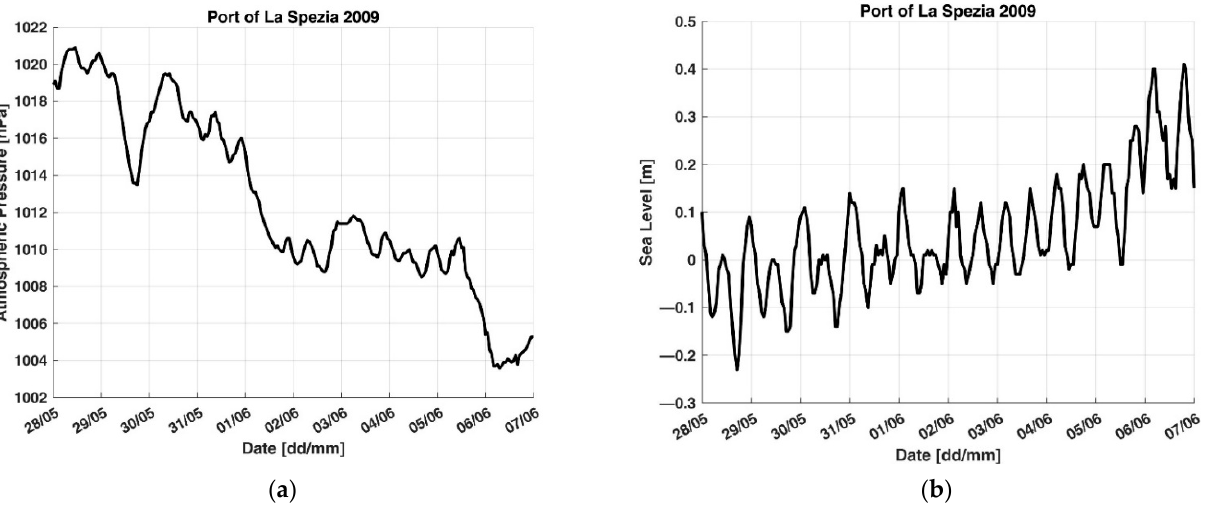
Figure 3. Measurements carried out between 28 May and 7 June 2009 inside the port of La Spezia: ( a ) atmospheric pressure; ( b ) sea level.